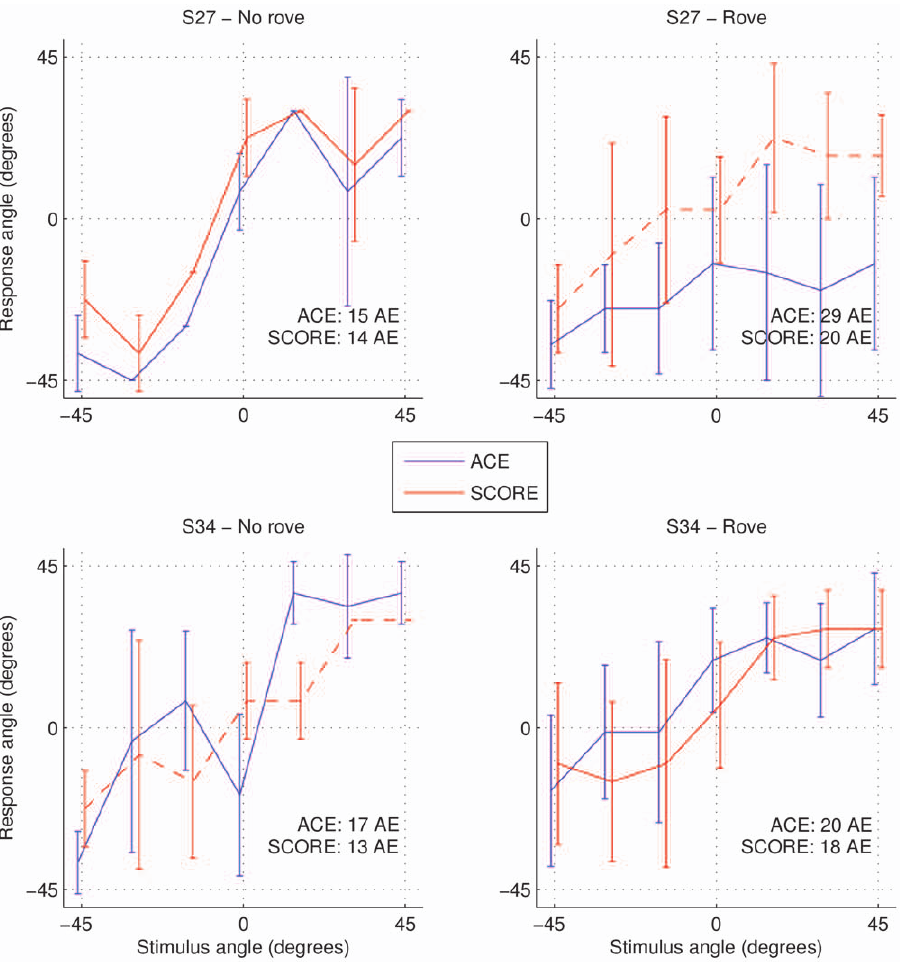
Figure 9. Localisation results with ACE and SCORE with and without level roving. For each angle the average response and corresponding standard deviations are shown. The overall absolute localisation error (AE) in degrees is shown for each